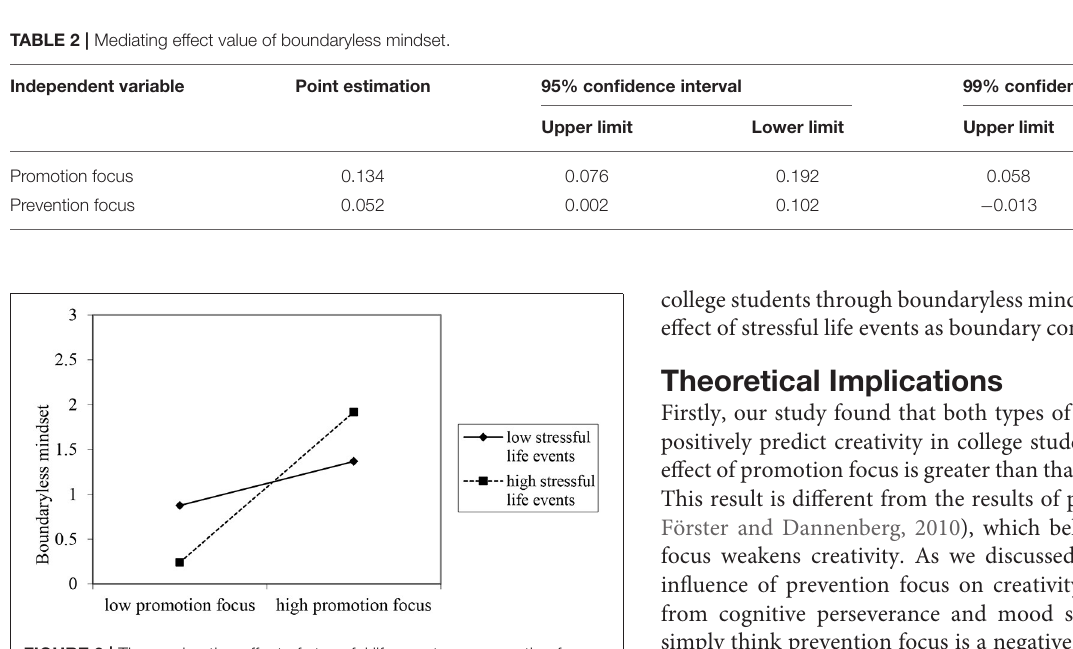
FIGURE 3 | The moderating effect of stressful life events on promotion focus to boundaryless